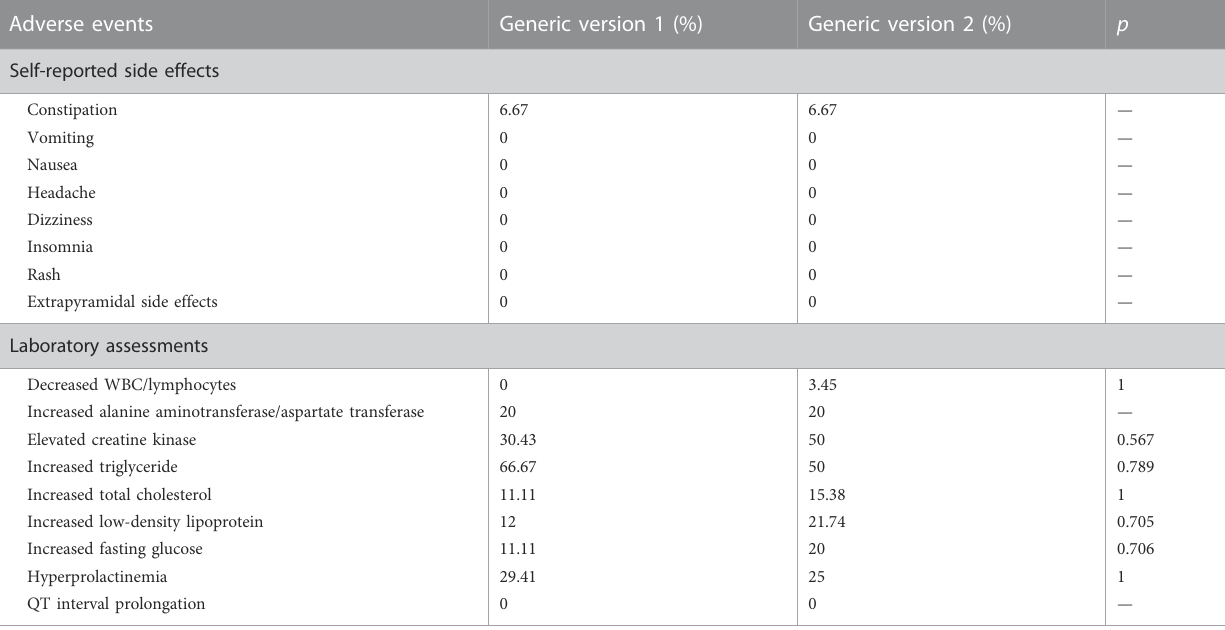
TABLE2Adverseeventsreportedbefore(genericversion1,theoriginalgenericolanzapine)andafter(genericversion2,thebid-winningolanzapine)drugswitch. Adverse